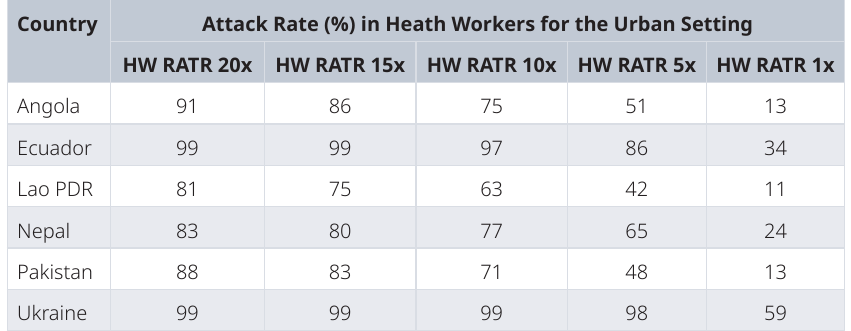
Table 2. Overall SARS-CoV-2 attack rate among health workers (HW) for the two- year period of simulation when varying the relative acquisition/transmission rate (RATR) for the health worker cohort. Country Attack Rate (%) in Heath Workers for the Urban